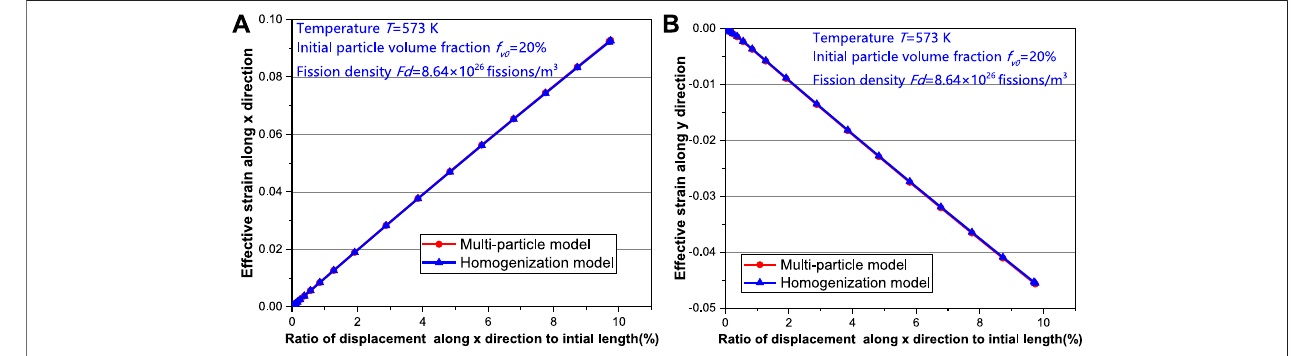
FIGURE 3 | Effective strains along (A) the x direction and (B) y direction.